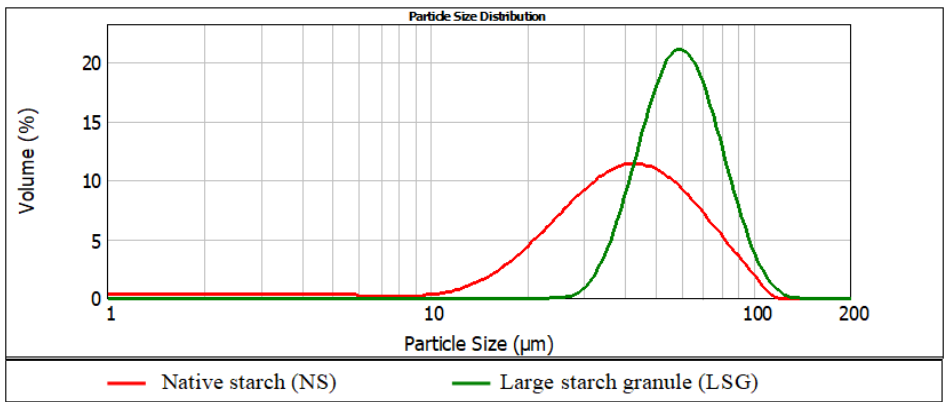
Figure 1. Particle size distribution of native starch (NS) and starch with homogenous fraction size determined using a laser particle size diffraction analyzer (LSD).